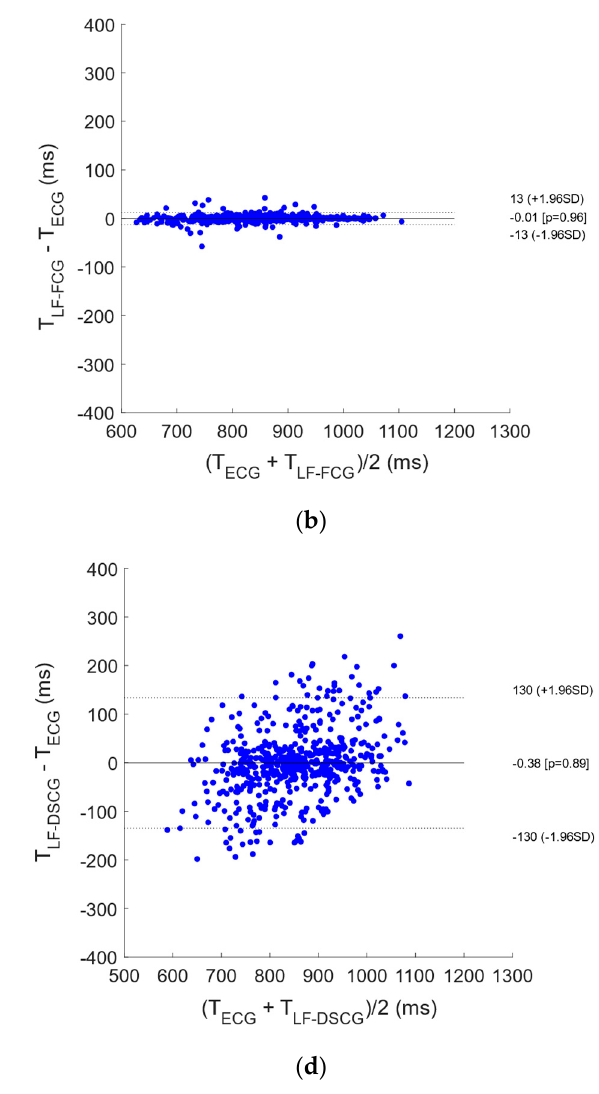
Figure 4. Statistical analyses on inter-beat intervals extracted from LF-FCG and LF-DSCG signals during apneas. ( a ) Results of regression and correlation analyses of LF-FCG vs. ECG; ( b ) results of Bland-Altman analysis of LF-FCG vs. ECG; ( c ) results of regression and correlation analyses of LF-DSCG vs. ECG; ( d ) results of Bland-Altman analysis of LF-DSCG vs. ECG.